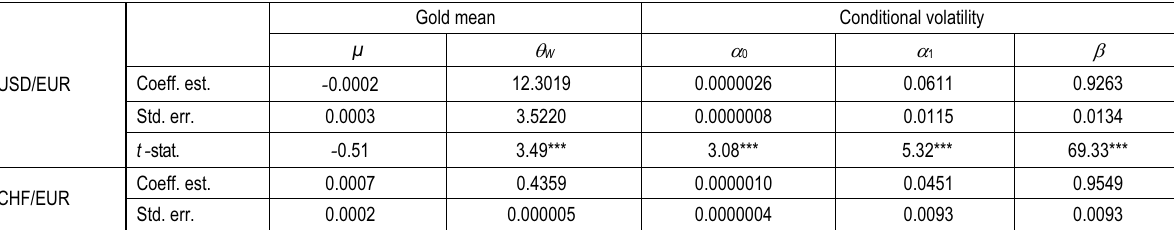
Table 5. Estimation results for Euro exchange